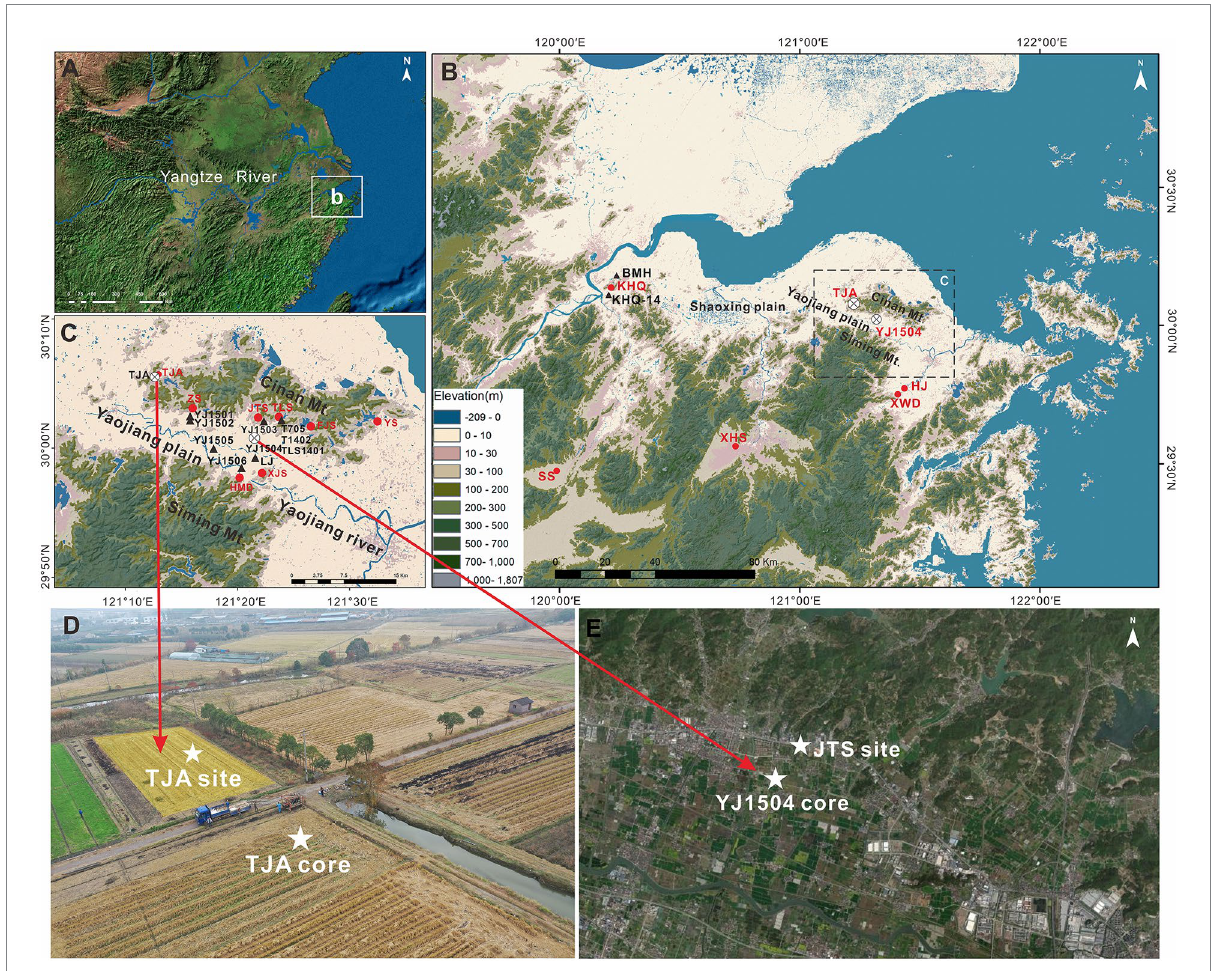
FIGURE 1 (A) Geographic background and location of the study area. (B) Location of the lower Yangtze river. (C) Location of the Yaojiang valley. (D) Location of the TJA core. (E) Location of the YJ1504 core. Red dots represent archaeological sites and black triangles represent cores mentioned in the present study. The location of the core sites of TJA and YJ1504 is marked with the black and white dots. SS, Shangshan site; XHS, Xiaohuangshan site; KHQ, Kuahuqiao site; JTS, Jingtoushan site; TJA, Tongjia’ao site; TLS, Tianluoshan site; HMD, Hemudu site; XJS, Xiangjiashan site;